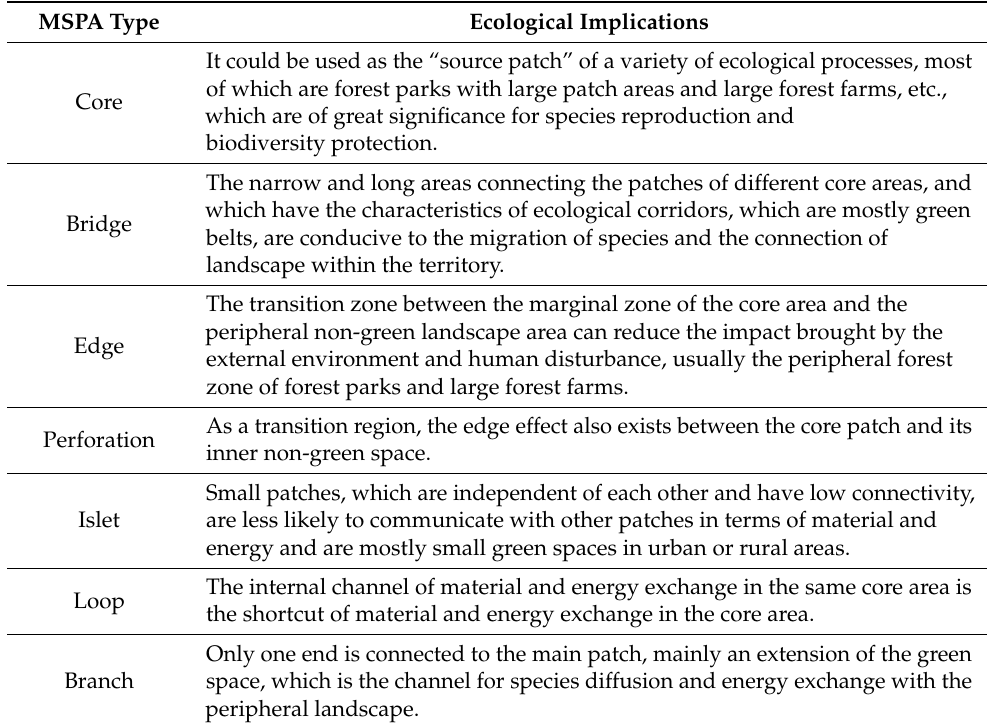
Table 2. Ecological implications of MSPA